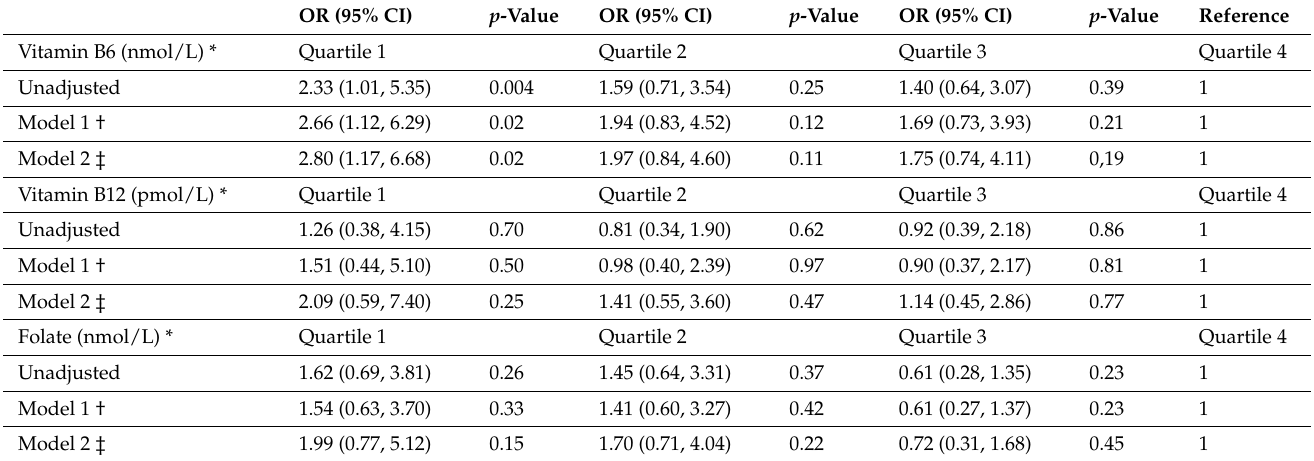
Table 5. Odds ratios of low birth weight for vitamins B6, B12 and folate concentrations. OR (95% CI) p -Value OR (95% CI) p -Value OR (95% CI) p